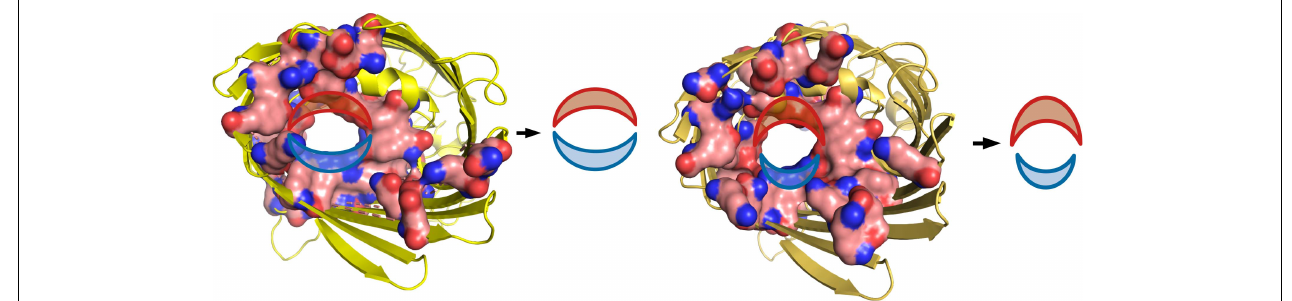
FIGURE 5 | Oxygen- and nitrogen-rich areas in OmpC (left) and OmpF (right) ion